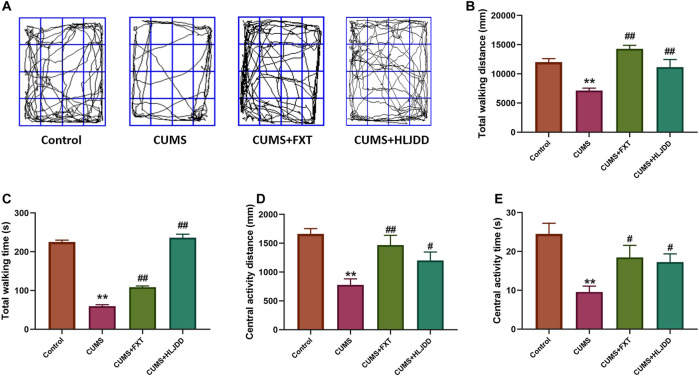
OFT results showing effect of HLJDD on behavior of CUMS mice. (A) Trajectory of an individual mouse over a 5-min testing session in the OFT; (B) Total distance covered by mice in the three groups 1 h after treatment; (C) Total time of movement for mice in the three groups taken 1 h before the testing; (D) Distance covered by mice at the center of open field in all groups 1 h after oral gavage; (E) Time spent by mice to move at the center of arena with or without CUMS stress and CUMS mice with the treatment of HLJDD or FXT 1 h after oral gavage. Data are expressed as Mean ± SEM, n = 10 mice per group. **p < 0.01, compared with Control; #p < 0.05, ##p < 0.01, compared with CUMS via ANOVA.